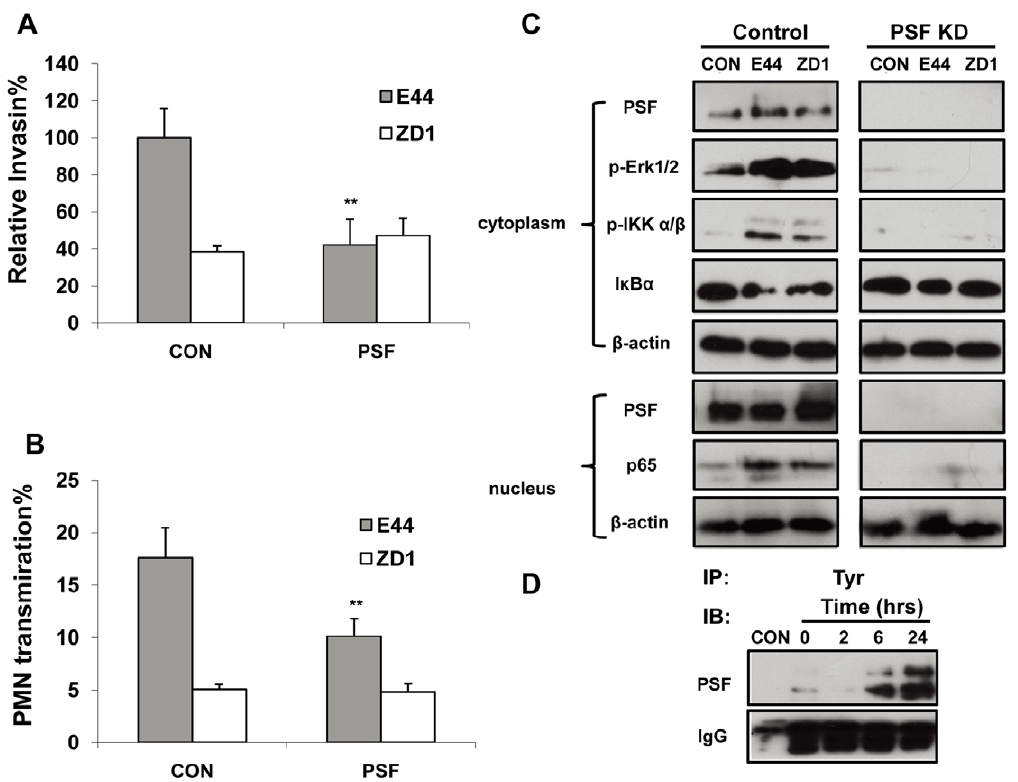
Figure 7. Inhibition of IbeA + E.coli K1-induced pathogenicities, phosphorylation of ERK/IKK and nuclear translocation of NF- k B by knockdown of PSF. HBMECs were transfected with PSF or control siRNA as described in Materials and Methods. IbeA + E. coli K1 penetration ( A ) and PMN transmigration ( B ) across siRNA-transfected HBMECs were performed as described in the Materials and Methods. Both invasion and PMN transmigration assays were performed in triplicates. Results for invasion are expressed as a relative percentage compared to the penetration rate of E44 in the siRNA control (CON) (100%). Results for PMN transmigration are expressed as the percentage of PMN transmigration of total PMNs. The control siRNA-transfected HBMECs infected with E44 and ZD1 were used as the controls (panels A and B). The significant differences regarding to the control were marked by asterisks (*P , 0.05; **P , 0.01). ( C ) After transfection, the cells were stimulated with E44 or ZD1 (10 7 /ml) for 30 min or 2 h. PSF re-localization, p-Erk1/2, p-IKK a / b and I k B a degradation were examined in cytoplasmic fractions after 30 min of stimulation with E. coli K1 strains. NF- k B (p65) and PSF in nuclear fractions were examined after 2 h of incubation with E. coli K1 strains. b -actin in both fractions was detected as internal loading controls. Control: HBMECs transfected with control siRNA; PSF KD, HBMECs transfected with PSF siRNA; UNT: Untreated HBMECs. ( D )